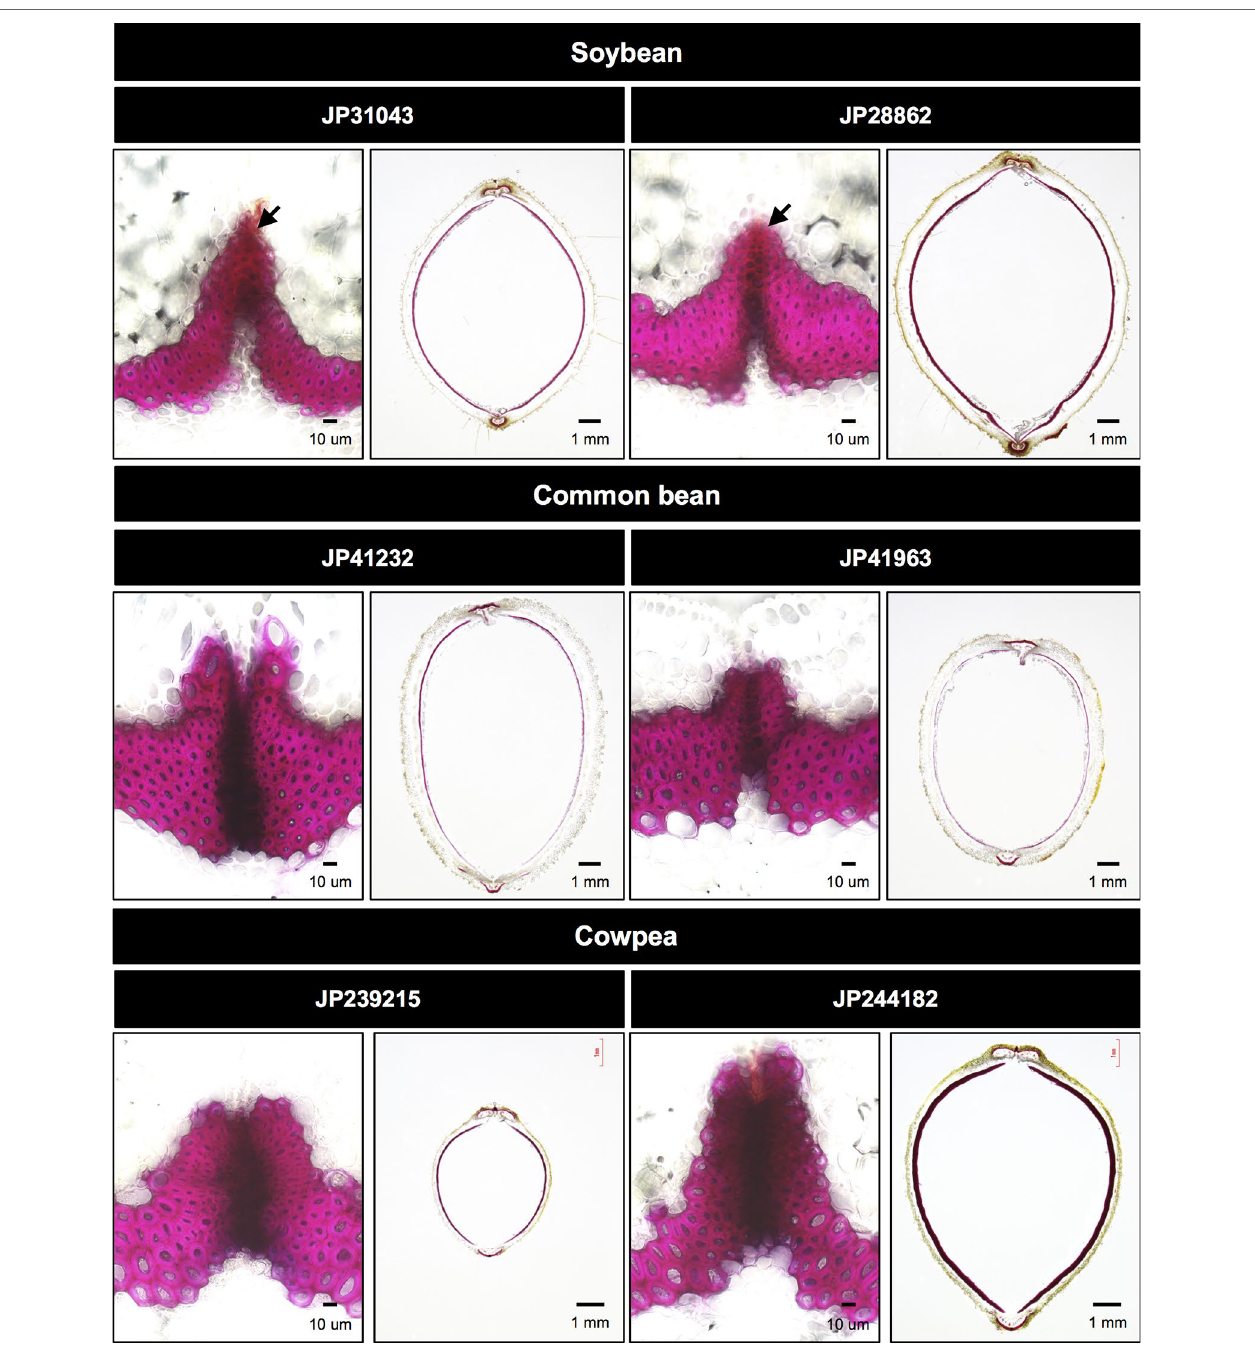
FIgURe 3 | Cross-sections of seed pods in domesticated accessions. The left panel of each accession is a close-up of abscission zone. Phloroglucinol-HCl stains pod sclerenchyma with bright red while it stains abscission zone with dark red. Soybean accessions have brightly-stained sites at the tip of fiber cap cells (arrows), which indicates abscission layer is not completely